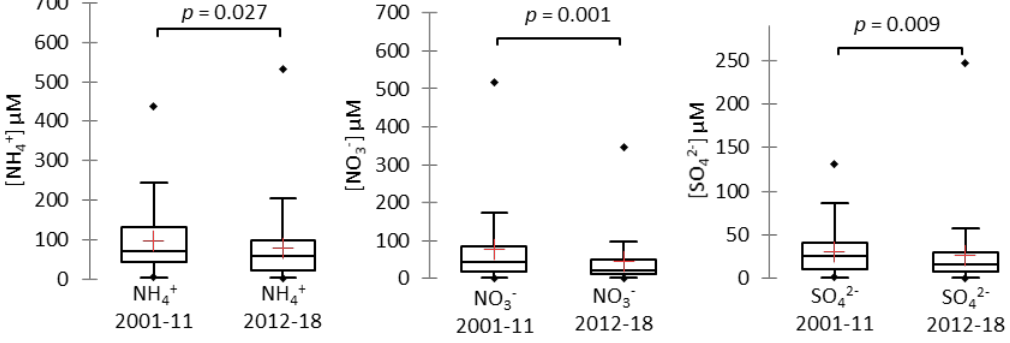
Figure 5. Mann–Whitney nonparametric tests on 154 clouds sampled from 2001 to 2011, the period covered by the previous study [46], and 88 clouds sampled from 2012 to 2018. We compare, for both periods, NH 4+ , NO 3− , and SO 42− concentrations. The p -values of all pairwise comparisons are significant at level alpha = 0.05.